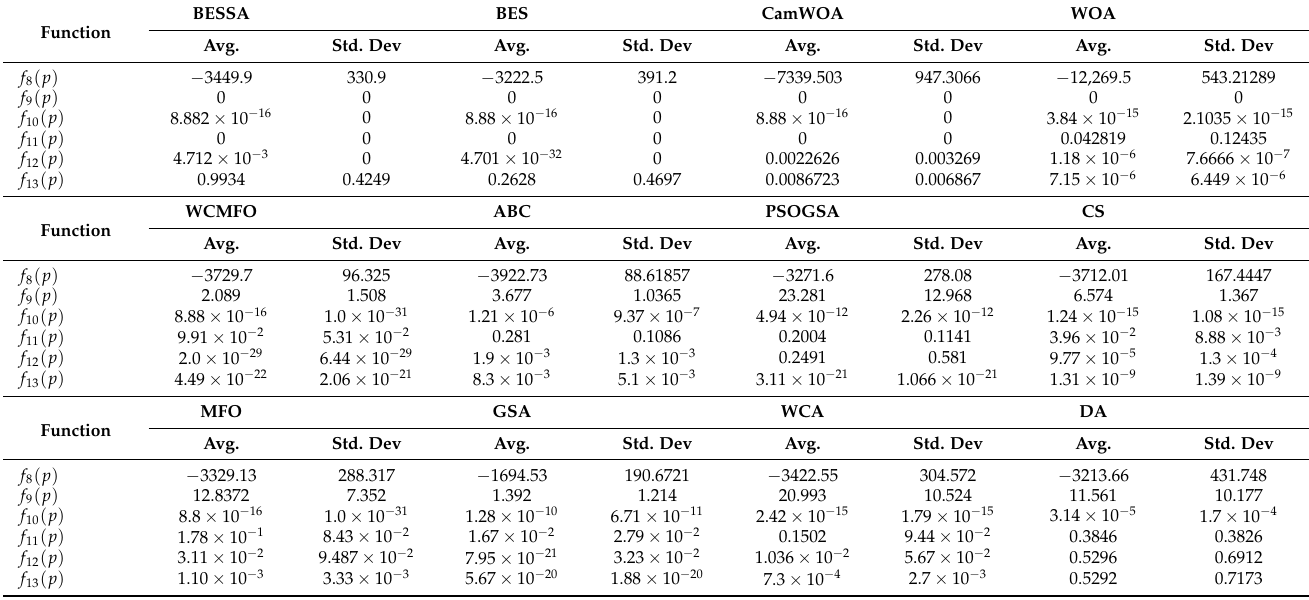
Table 4. Multimodal benchmark functions statistical